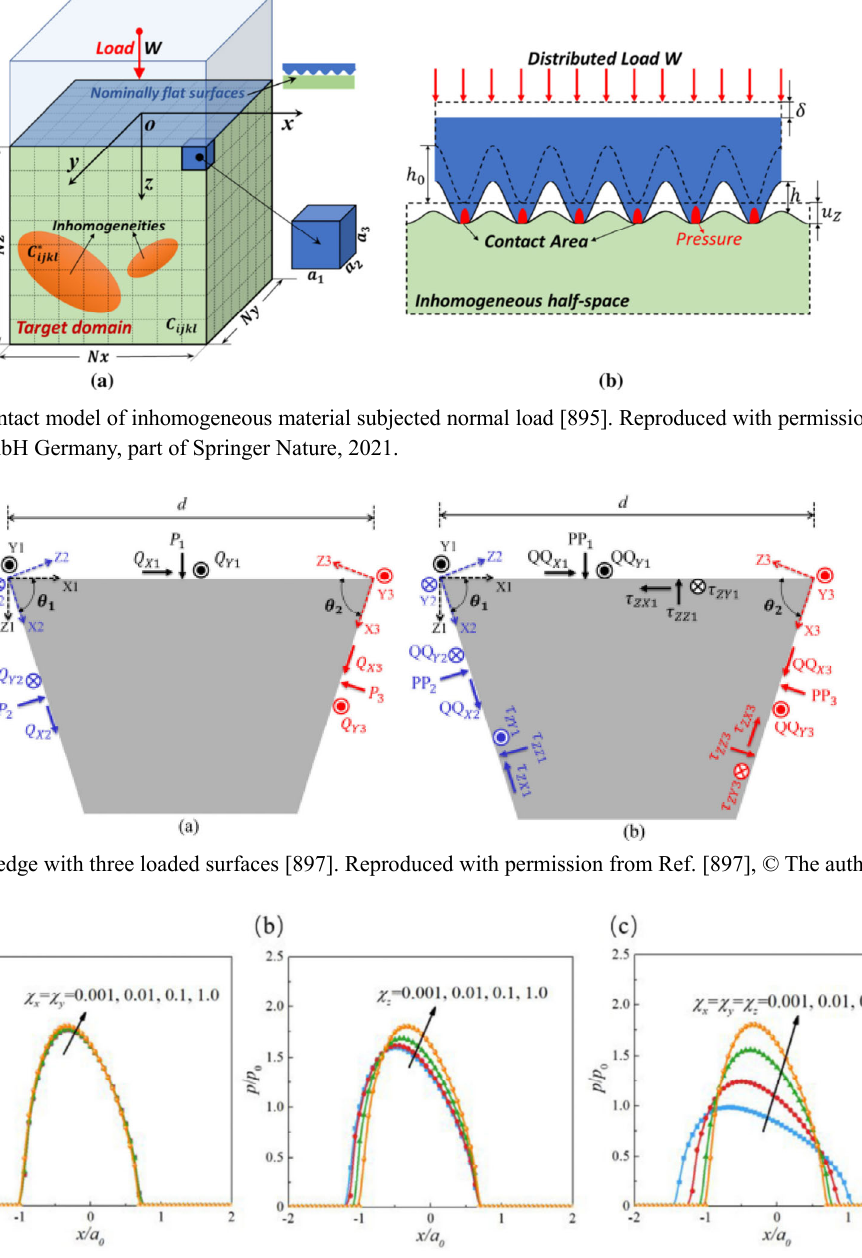
Fig. 68 Pressure distributions due to different interfacial imperfection indices. (a) Individual lateral imperfection with (cid:2031) z = 1.0, (cid:2031) x = (cid:2031) y = 0.001, 0.01, 0.1, 1.0; (b) individual vertical imperfection with (cid:2031) x = (cid:2031) y = 1.0, (cid:2031) z = 0.001, 0.01, 0.1, 1.0; and (c) combined lateral and vertical imperfections with (cid:2031) x = (cid:2031) y = (cid:2031) z = 0.001, 0.01, 0.1, 1.0 [898]. Reproduced with permission from Ref. [898], © Springer-Verlag GmbH Germany, part of Springer Nature,